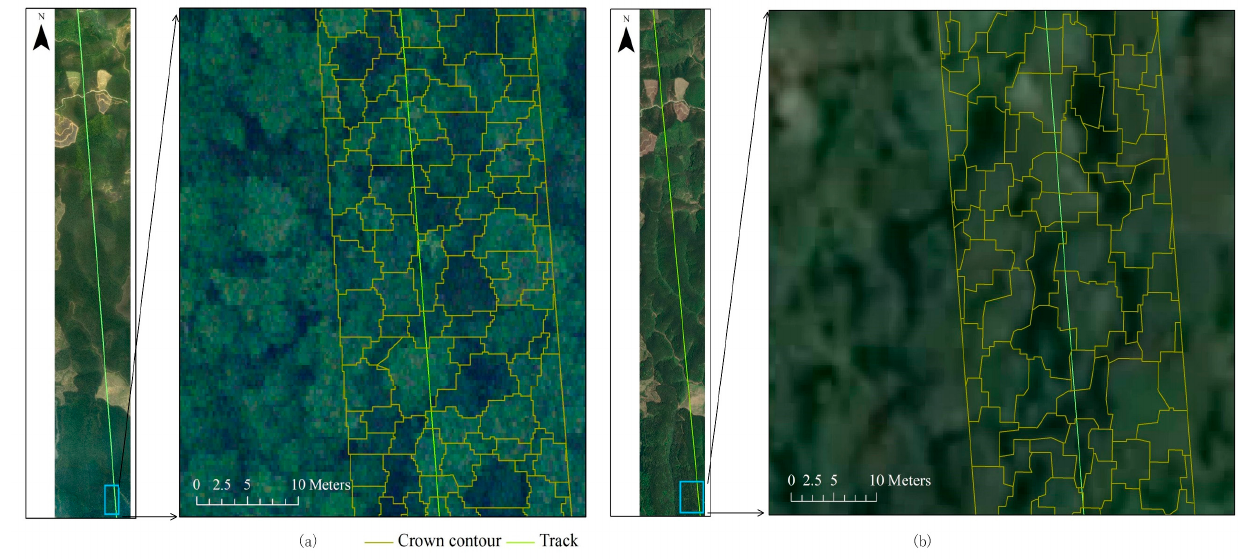
Figure 7. Example of segmentation results of the ( a ) CAF–LiCHy DOM data and ( b ) Google Earth image.